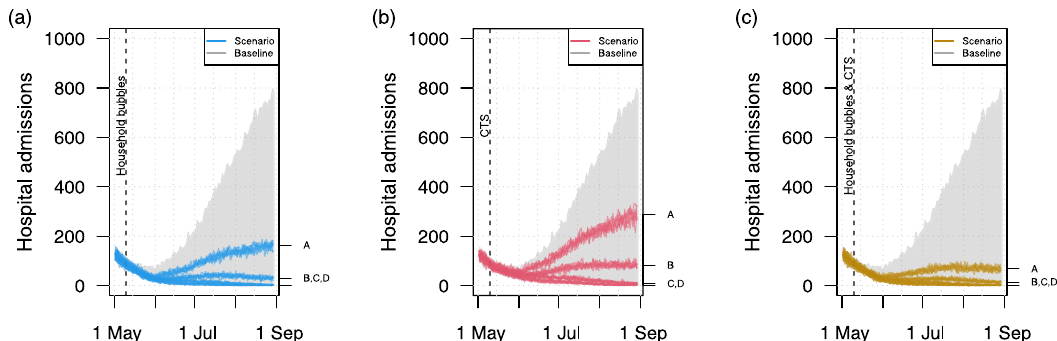
Fig. 2 Impact of household bubbles and contact tracing on hospital admissions. Hospital admissions over time when community mixing occurs in household bubbles ( a ), contact tracing strategy is in place ( b ), or both ( c ). All scenarios are based on the same natural disease history and quantitative mixing assumptions, but differ from the baseline in terms of the network structure and application of contact tracing from the given point in time. The mixing assumptions A,B,C,D are explained in the caption of Fig. 1. CST contact